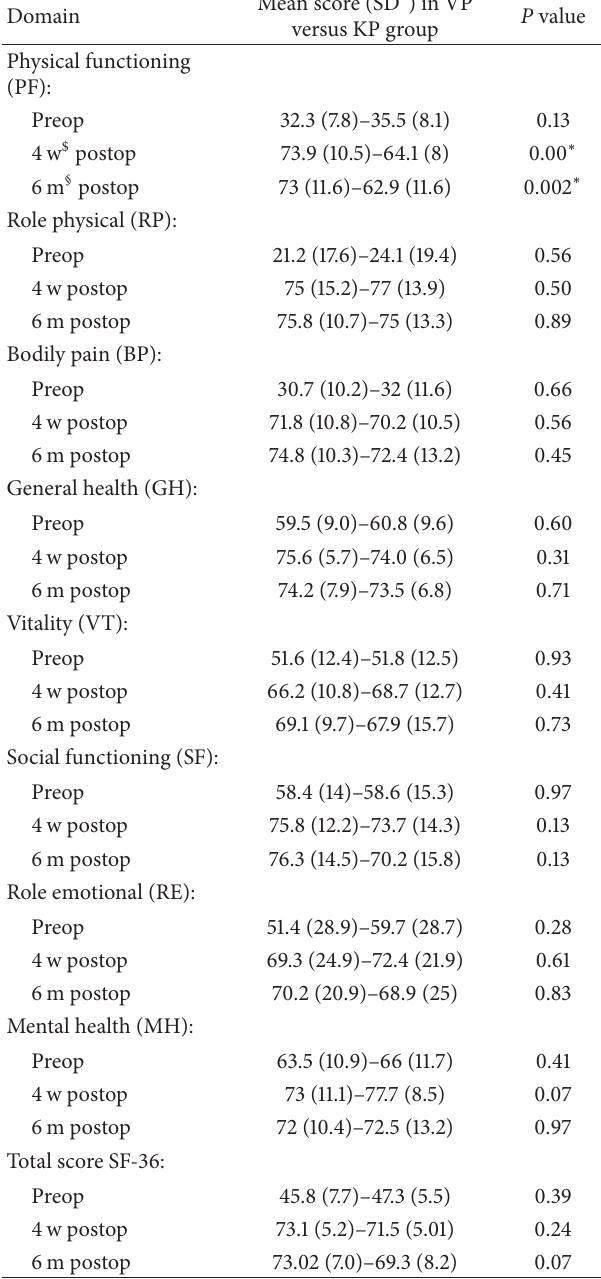
Table 1: Comparison of the effects of VP and KP on eight domains of SF-36 in our